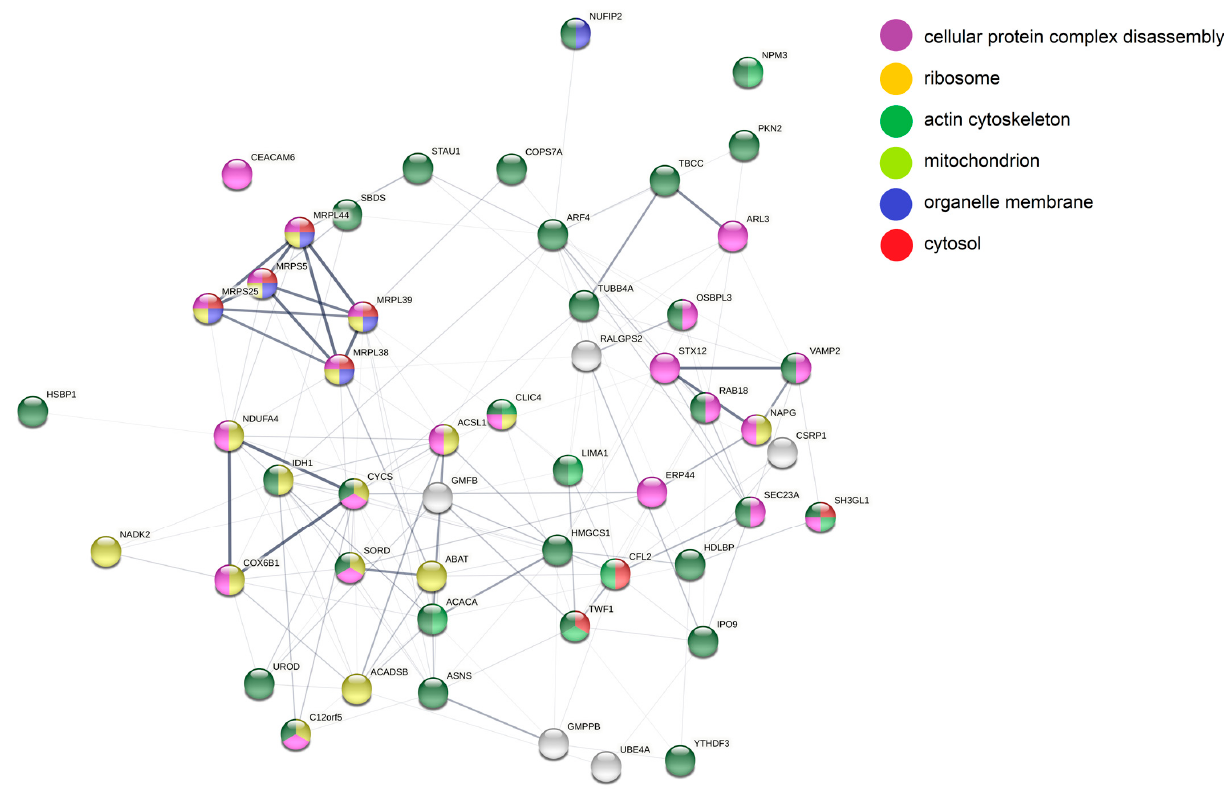
Figure 8. STRING analysis of proteins more abundant in both knockout cell lines. Nodes represent individual proteins and are colored based on the annotations placed at the right side of the figure. Line strength specifies confidence level from lowest (0.150) to highest (0.900).